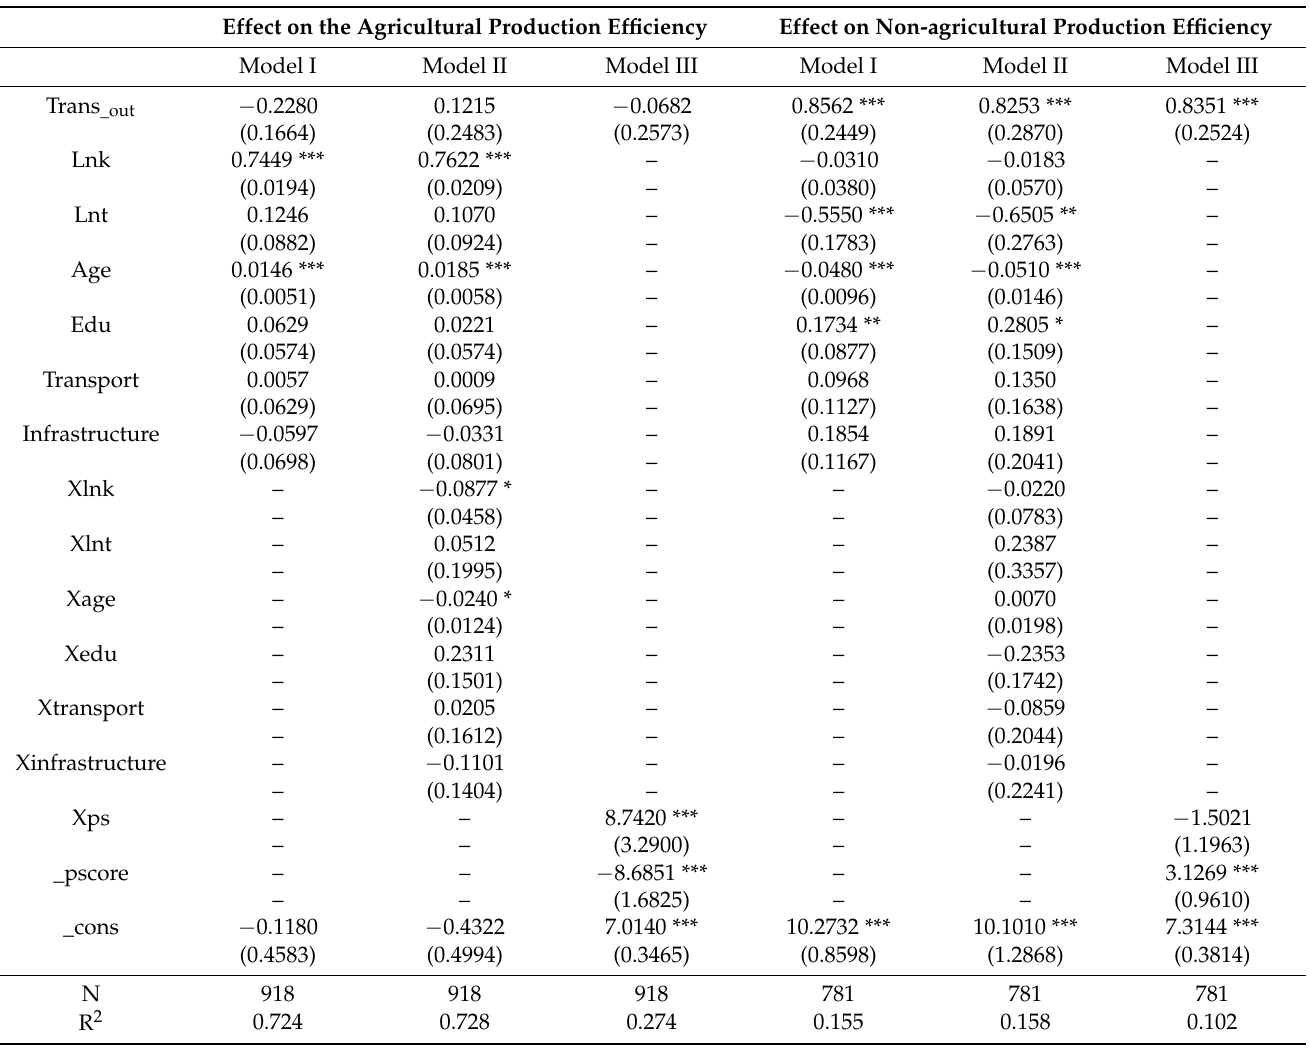
Table 9. Effect of Land transfer-out on Different Kinds of Labor Productivity of Farmer